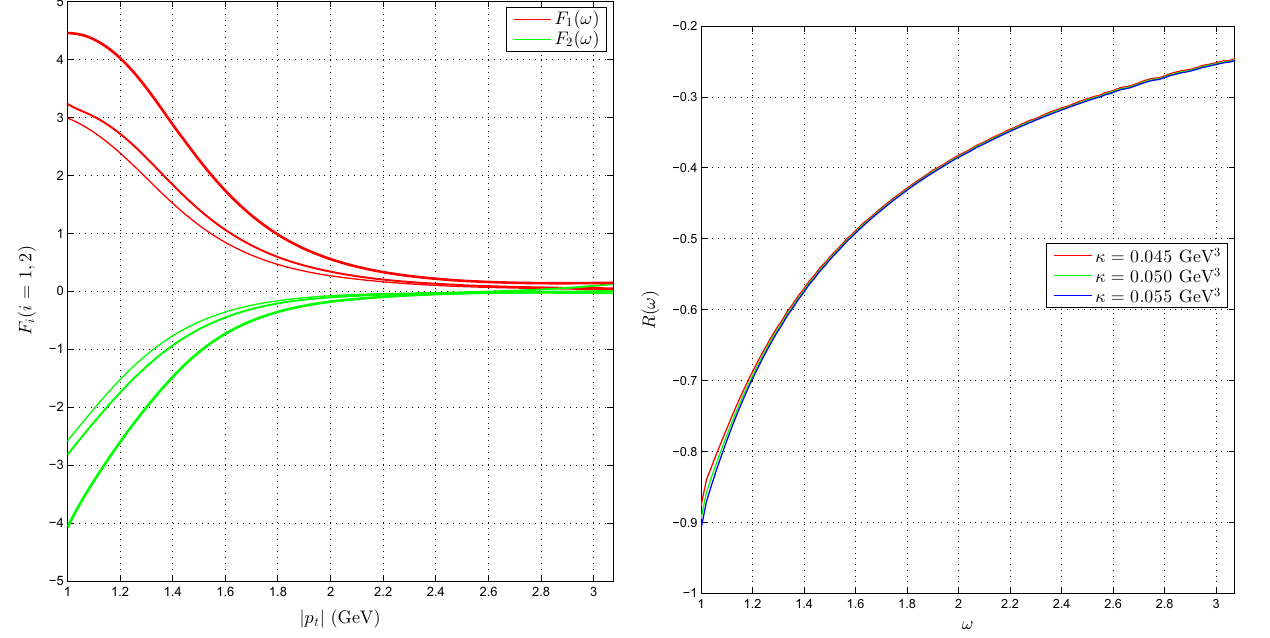
Fig. 4 The values of FFs (the lines become thicker with the increases of κ ) and R (ω) with different values of κ